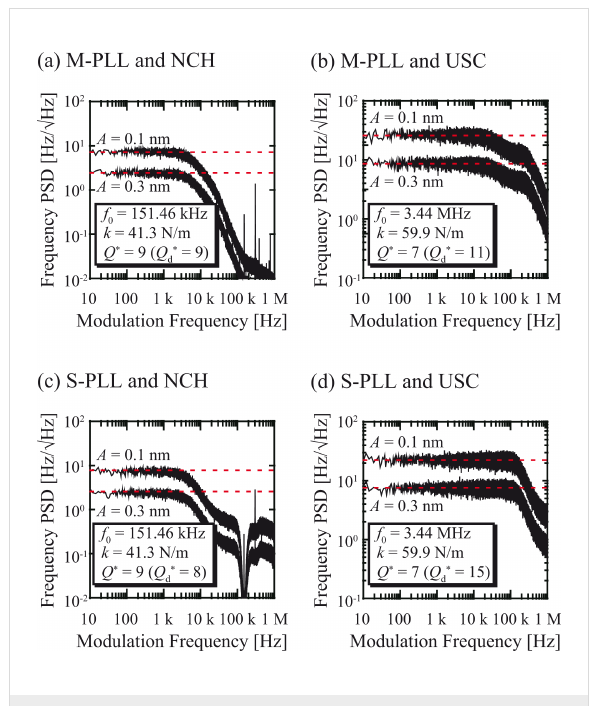
Figure 8: Frequency power spectral density (PSD) distributions of the output signals from the (a, b) M-PLL and (c, d) S-PLL measured with the cantilevers immersed in liquid and using the (a, c) NCH and (b, d) USC